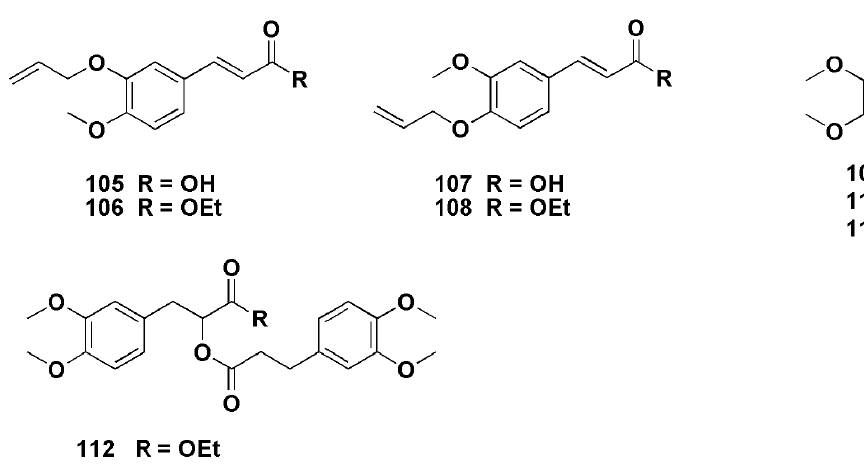
Figure 29. Chemical structures of compounds 105-112 [12].